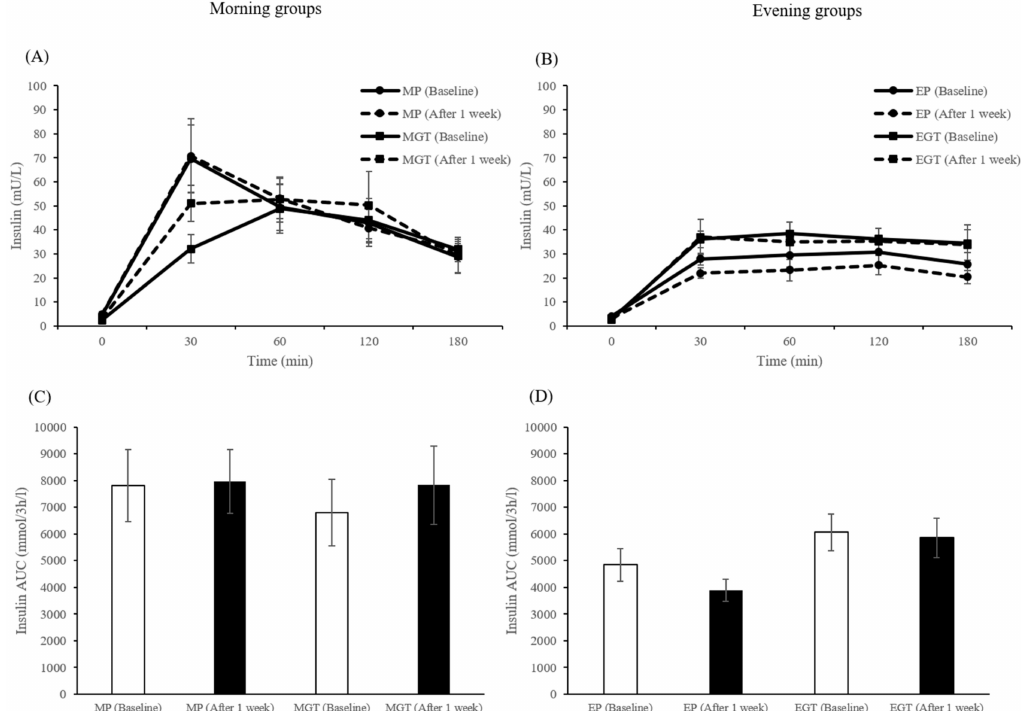
Figure 8. Concentrations and incremental area under the curve (AUC) of plasma insulin in the morning groups ( A , C ) and evening groups ( B , D ) in humans. Data are expressed as the mean and SEM, represented by bidirectional